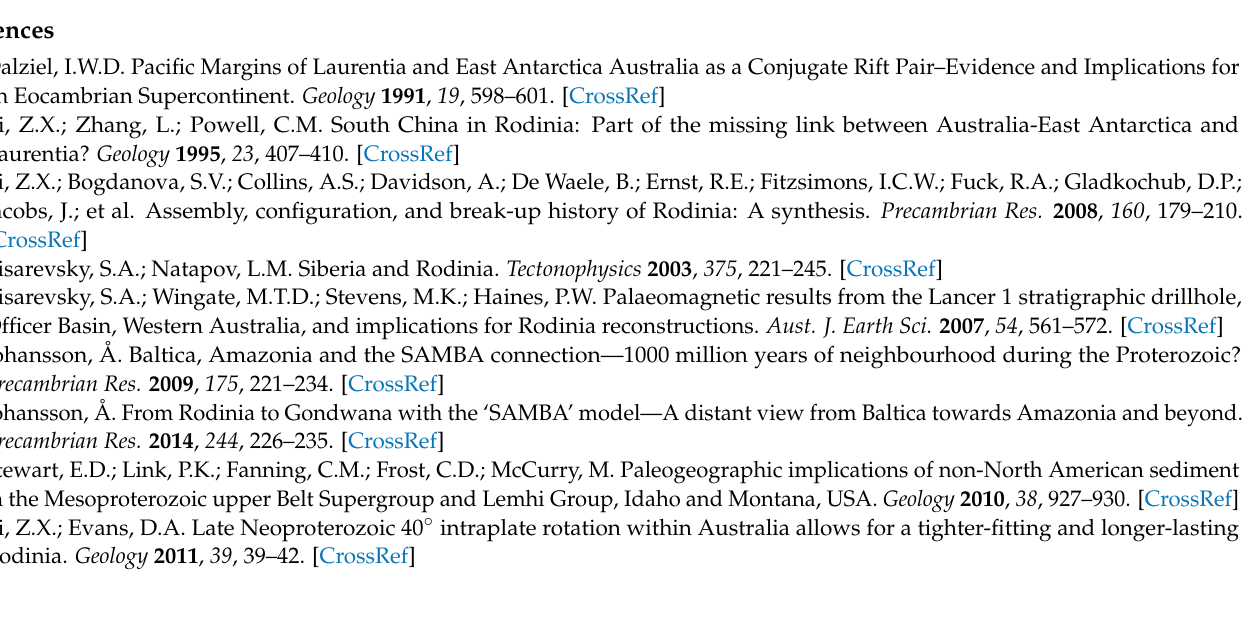
Table S2: LA–MC–ICP–MS zircon Hf isotope analytical